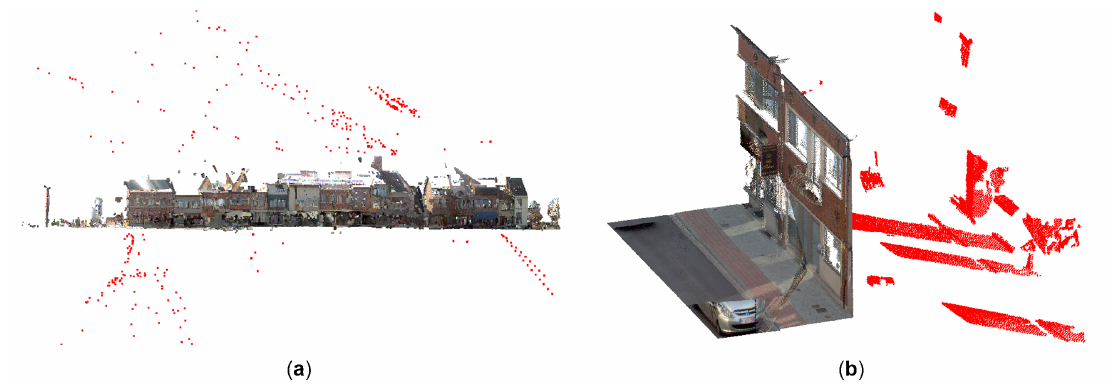
Figure 3. Visualization of subterranean/sky noise points ( a ) and ghosting points caused by measuring through glass ( b ). All noise and ghosting points are colored in